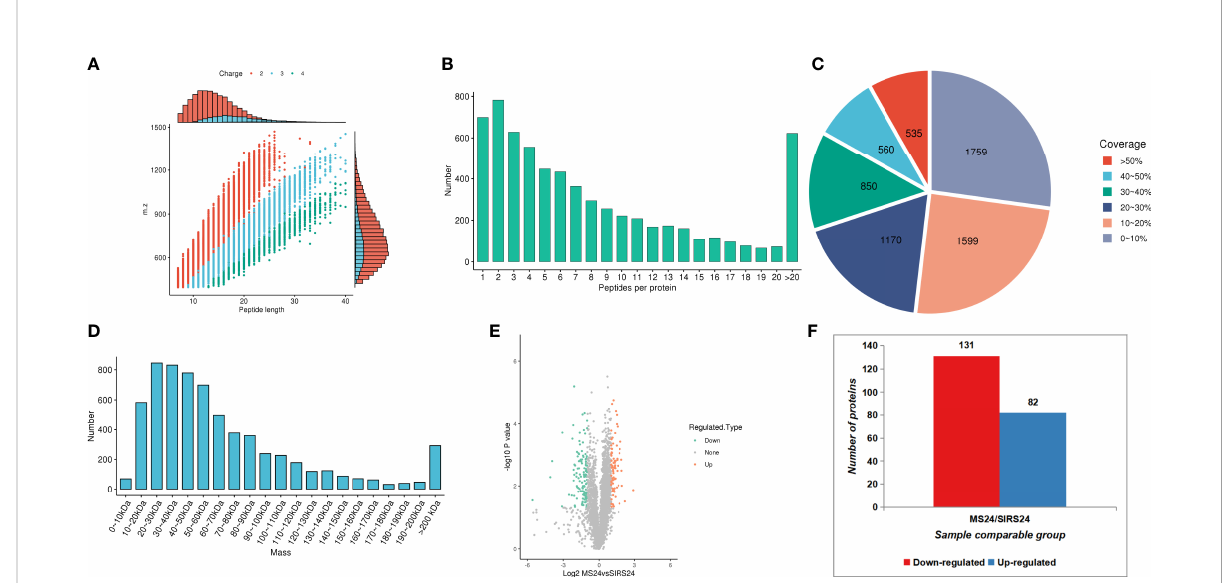
FIGURE 1 Proteomic quality control and DEPS identi fi cation after HUMSCs intervention. Peptide length distribution: most of the peptides were distributed in 7-20 amino acids (A) . Peptide number distribution: most proteins corresponded to more than two peptides (B) . Protein coverage distribution: the coverage of most proteins is below 30% (C) . Protein molecular weight distribution: the molecular weight of the identi fi ed protein is present at different stages and is evenly distributed (D) . Volcanogram showed the difference of protein expression between MS24 and SIRs24 group in lung tissue of juvenile septic rats (E) . The DEPS comparison between MS24 and SIRs24. 213 proteins were identi fi ed as DEPS (3.3% of 6438 proteins), of which 82 proteins were up-regulated and 131 proteins were down-regulated (F)